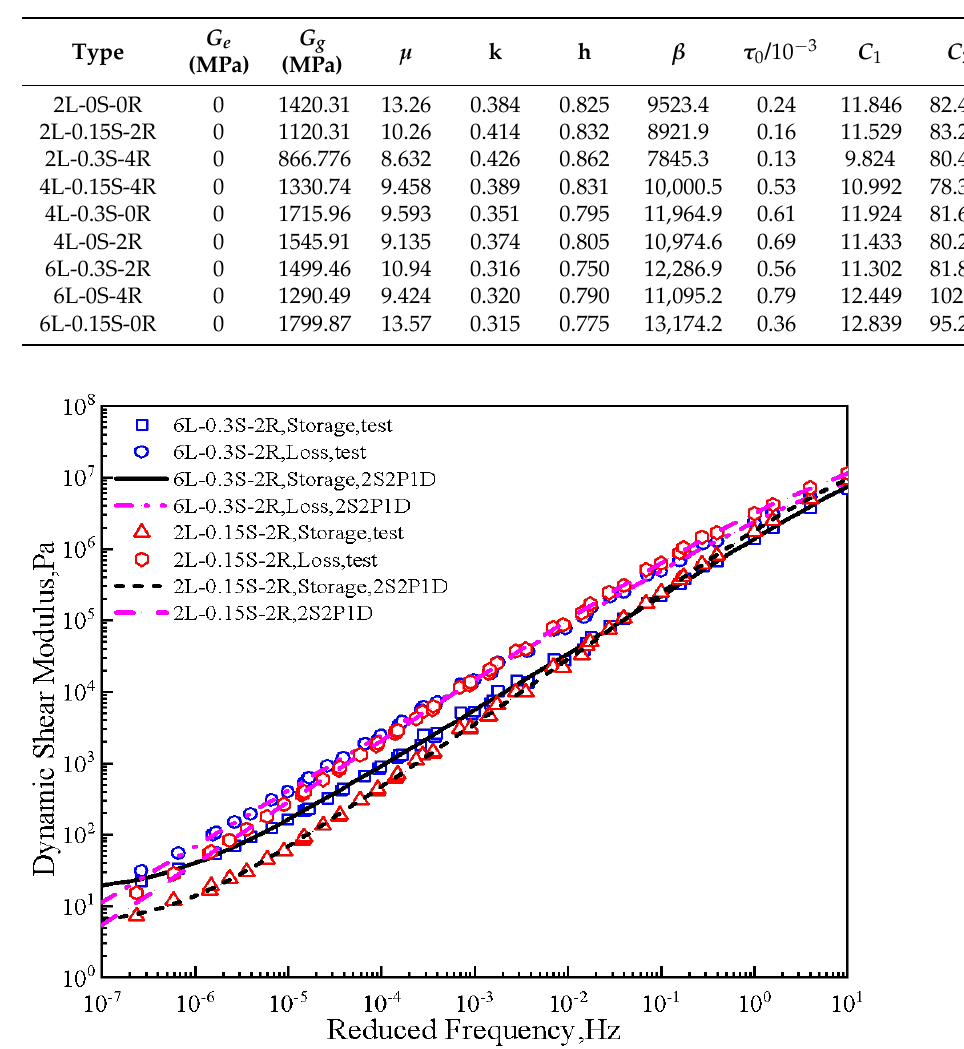
Figure 2. Modulus master curves of 6L‑0.3S‑2R and 2L‑0.15S‑2R